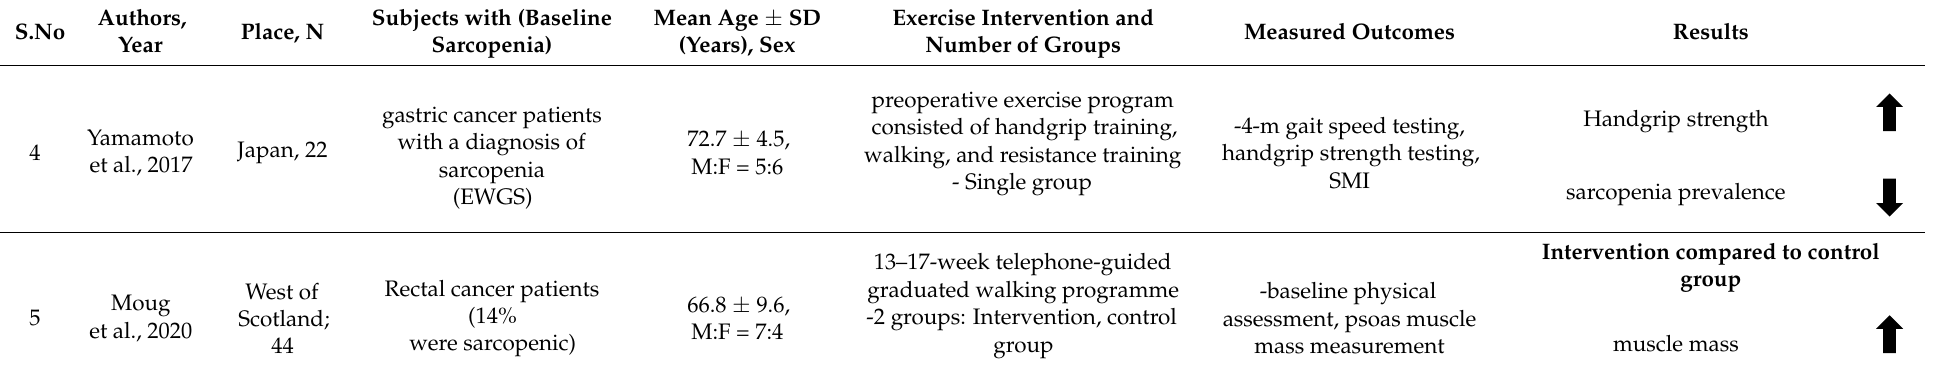
Table 1. Cont. Table 1. Effect of exercise on subjects with cancer and baseline measurement of sarcopenia.